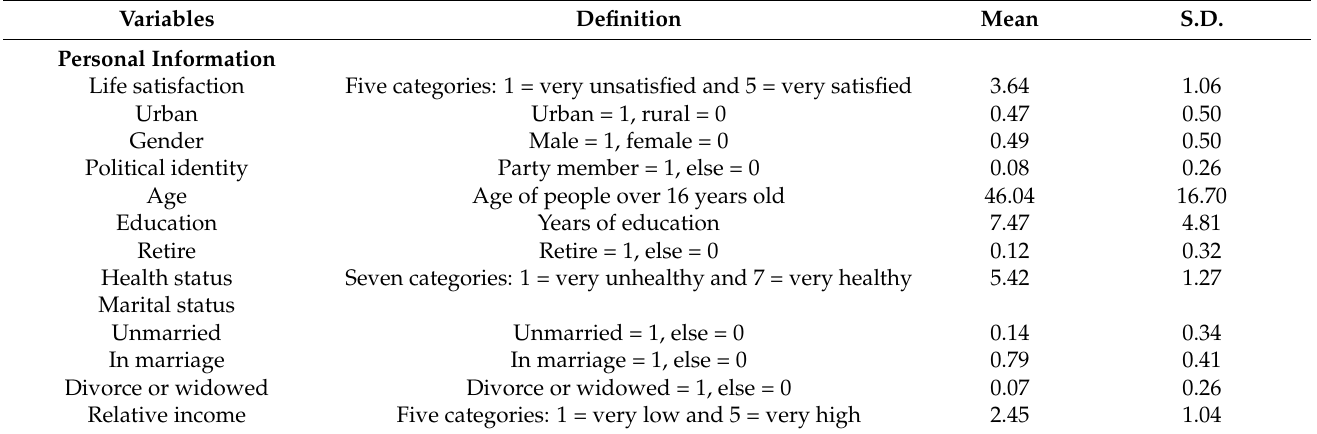
Table 1. Descriptive